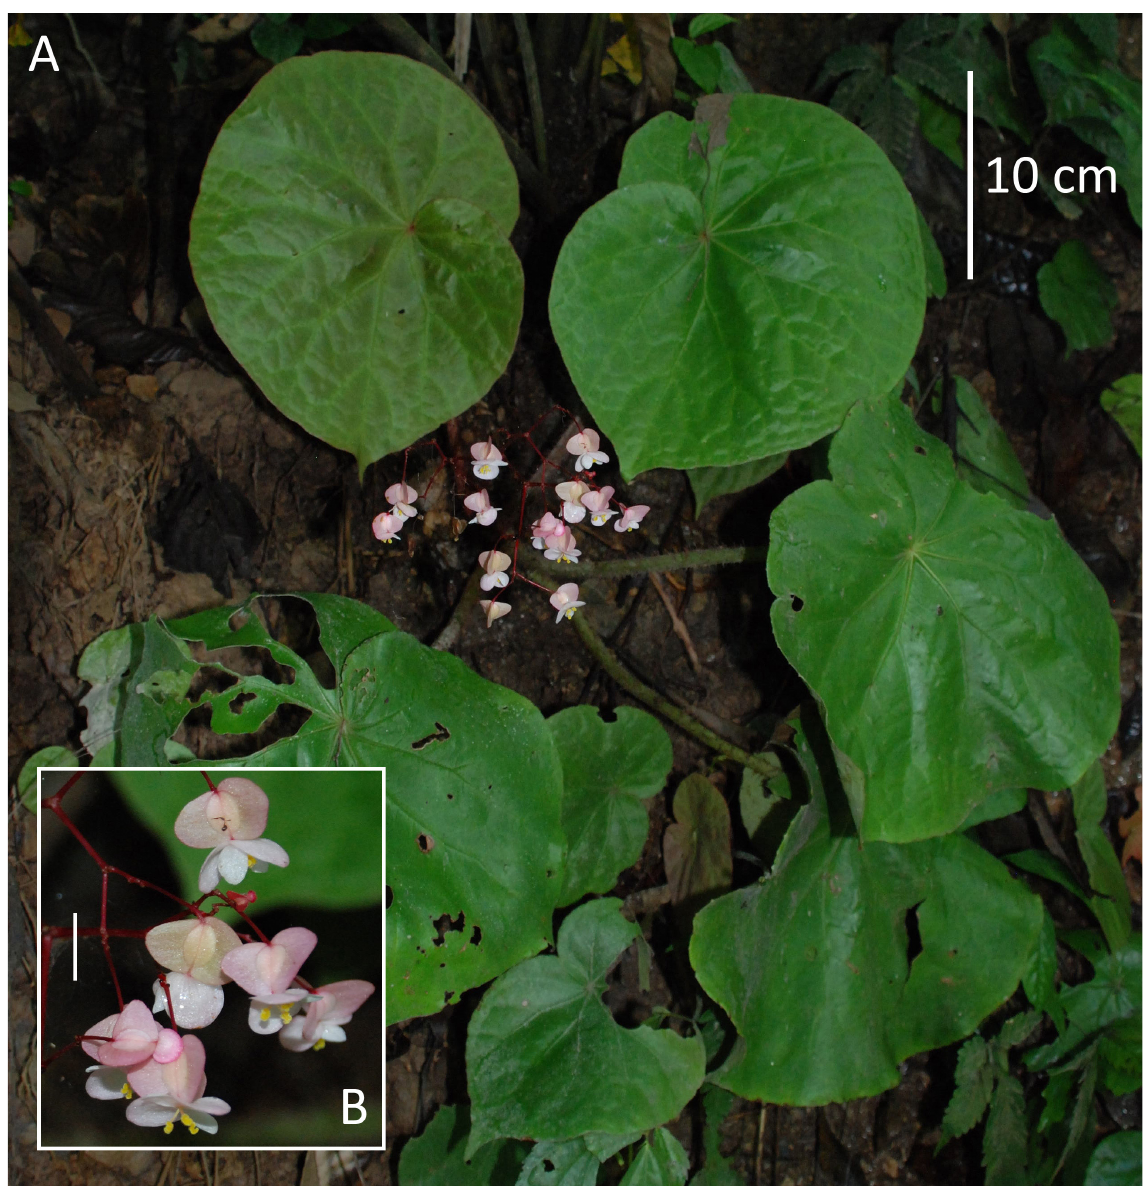
Fig. 16. Begonia raoensis M.Hughes sp. nov. A . Habit. B . Inflorescence in female phase (scale bar = 1 cm). Photographs from the Rao vicinity, of the type Hughes & Girmansyah MH1400